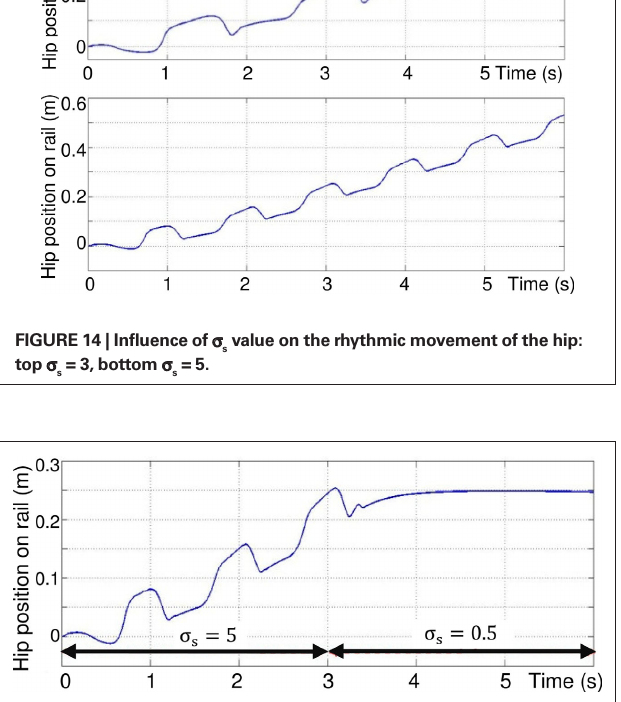
FiguRe 15 | Control of the walking pattern due to change in value of σ from 5 to 0.5 at time t = 3 s.